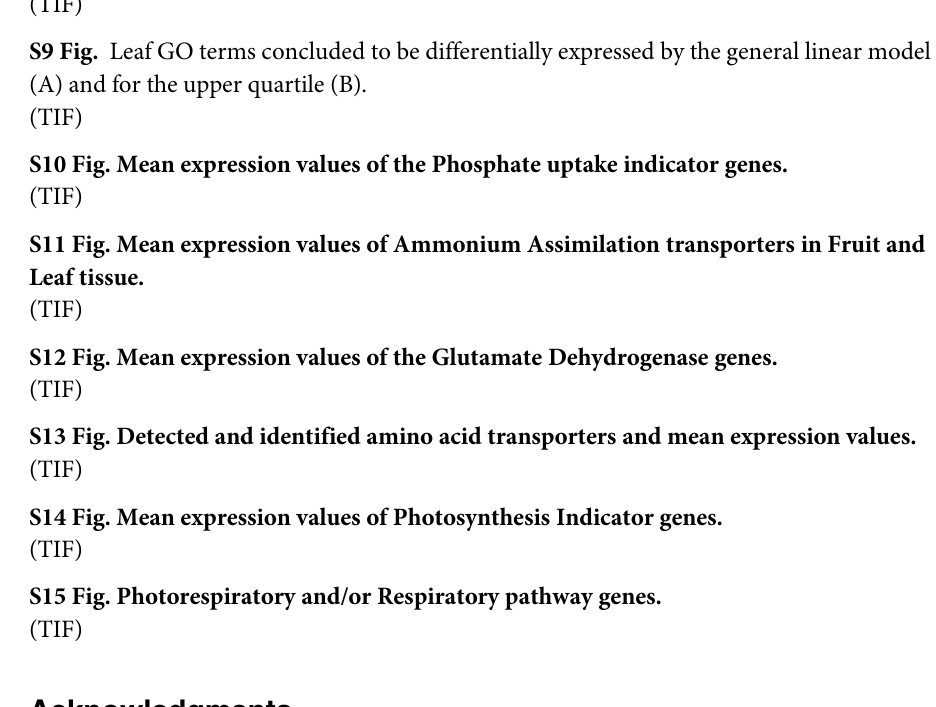
S10 Fig. Mean expression values of the Phosphate uptake indicator genes. S11 Fig. Mean expression values of Ammonium Assimilation transporters in Fruit and Leaf tissue. S12 Fig. Mean expression values of the Glutamate Dehydrogenase genes. S13 Fig. Detected and identified amino acid transporters and mean expression values. S14 Fig. Mean expression values of Photosynthesis Indicator genes. S15 Fig. Photorespiratory and/or Respiratory pathway